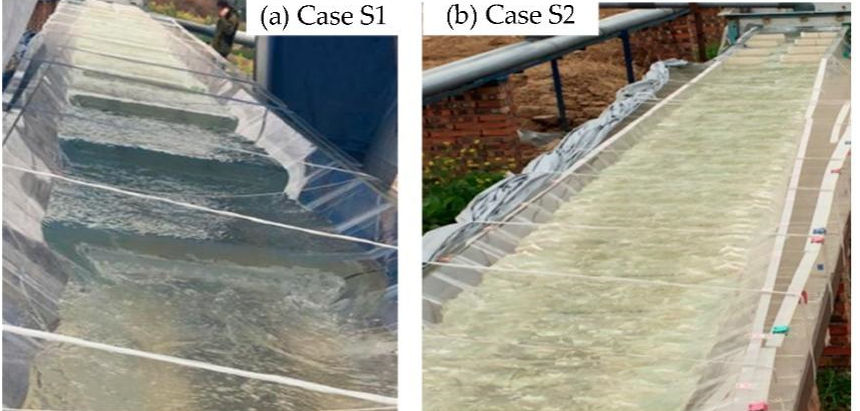
Figure 23. Water surface of the transition reach in Cases S 1 and S 2 in the hydraulic model. The waves on the water surface and the water drops are very obvious, where the local head drop around each weir plate is high, and the turbulent intensity is very strong ( a ). In Case S 2 , the gradient of the water surface became mild ( b ). It can be seen that the flow regime in the channel adopting the DWO became more gentle, without a strong vortex, which supplies the suitable mild dynamics of a migration environment.